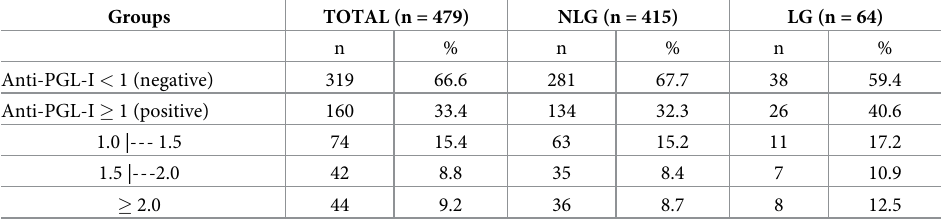
Table 5. Results of anti-PGL-I antibody measurements (anti-PGL-I index; cut off 0.295).